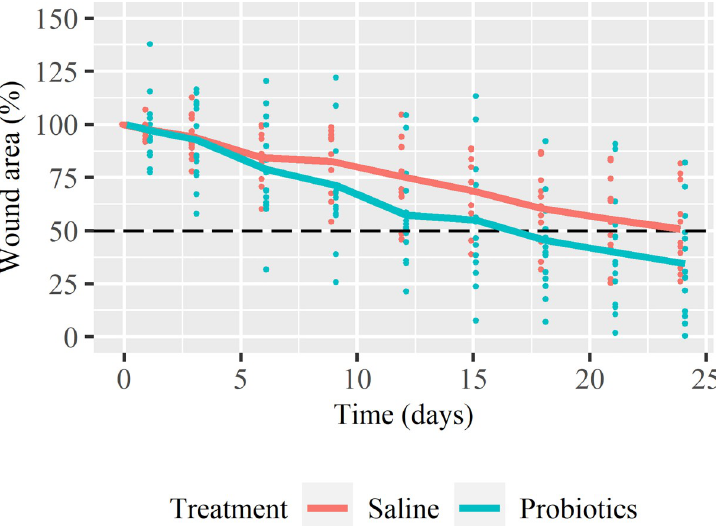
Fig 1. The relative wound area as a function of time. The relative wound area at day x is defined as the wound area measured at day x (cm 2 ) expressed as a percentage of the wound area measured at day 0 (cm 2 ). The dots represent the data of the individual wounds and the lines represent the mean relative wound area of all horses per treatment. The dashed line (- -) indicates the level of 50% wound repair. Data points of both groups are shifted a little for better visualization.